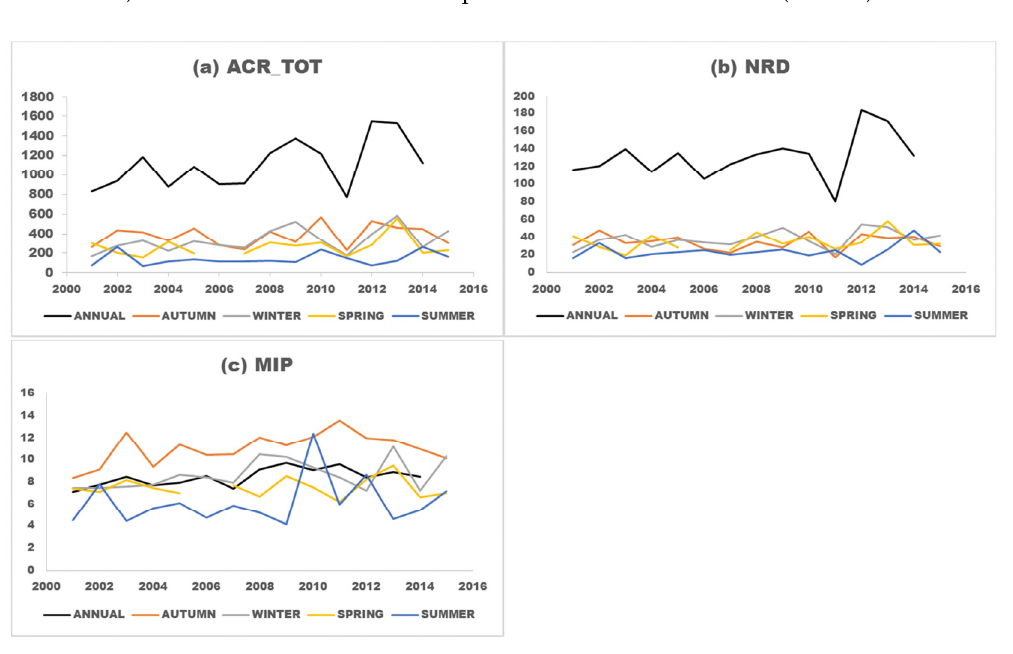
Figure 7. Annual and seasonal time series of ACR_TOT ( a ); NRD ( b ) and MIP ( c ). Water 2017 , 9 , 86